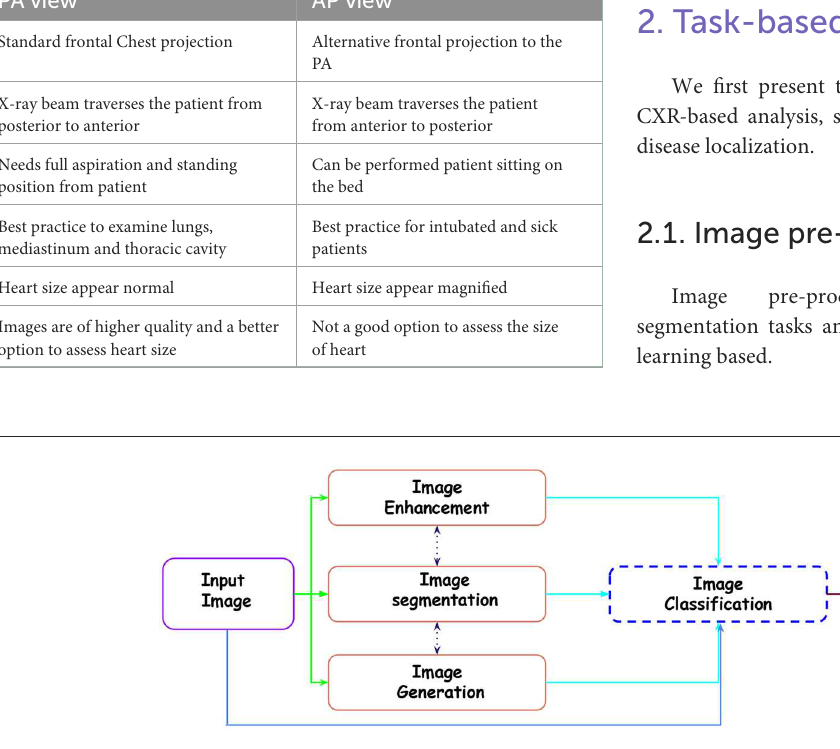
FIGURE2 Showcasing the transition across different tasks in CXR-based analysis for a given input